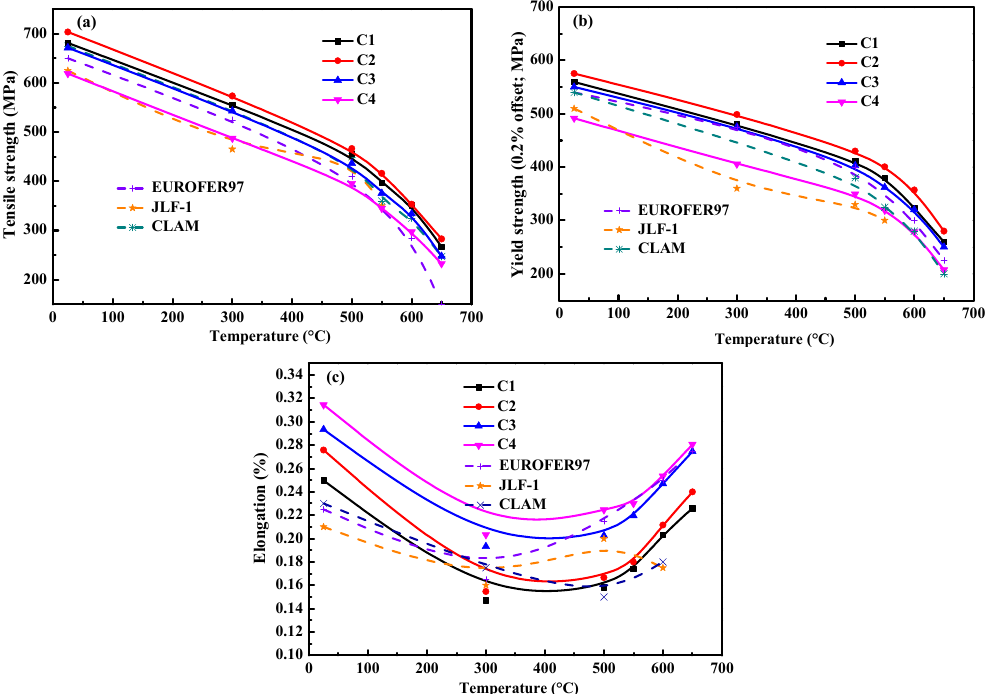
Figure 9. Tensile properties of the steels: ( a ) tensile strength, ( b ) YS, and ( c ) elongation. The data for Eurofer 97 [30], JLF-1 [31], and CLAM [28] are provided for comparison to the steel alloys analyzed in this study.